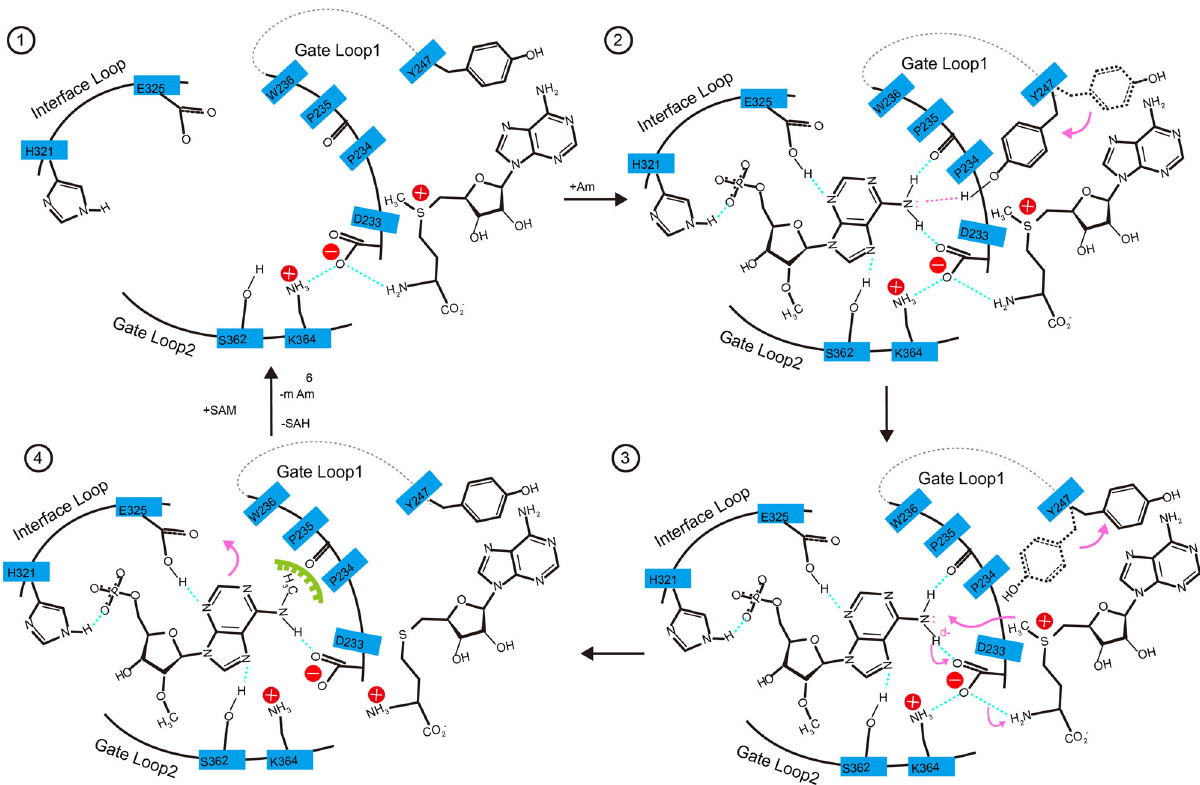
Fig.5|ProposedcatalyticmechanismofMETTL4. Diagrammaticpresentationof the catalytic mechanism of METTL4. In the initial step (1) the backbone phosphate of Am may be bound by H321 in interface loop; then, Y247 in the Gate Loop1